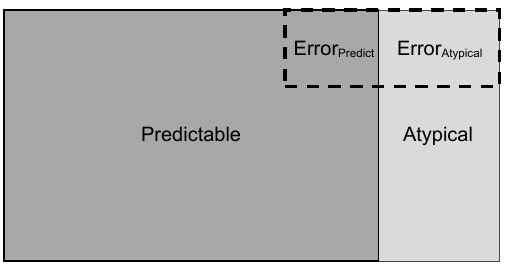
Fig. 5 Predictable and atypical cases given big data (and classification